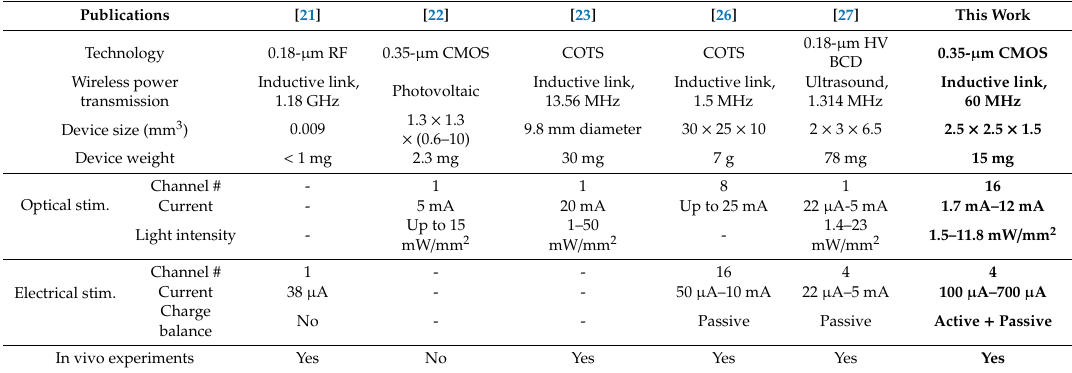
Table 2. FF-WIOS2 SoC Measured